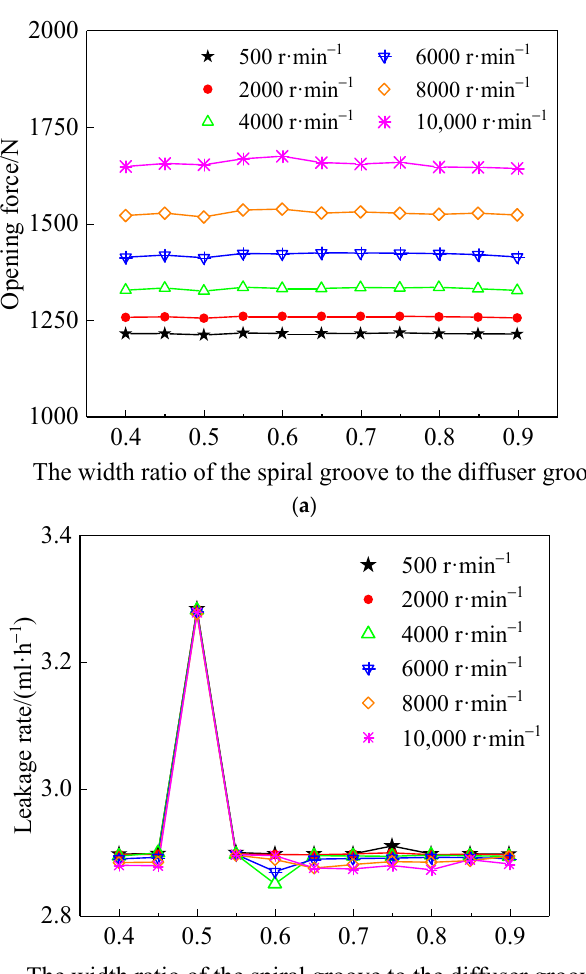
Figure 12. Influence of the width ratio of the spiral groove to the diffuser groove on the sealing performance: ( a ) Influence on the opening force; ( b ) Influence on the leakage rate. ( r k = 34 mm, h ki = h g = 50 μ m, r o = 30.6 mm, N g = 22, λ = 0.9, α = 30°, Δ p = 0.5 MPa).